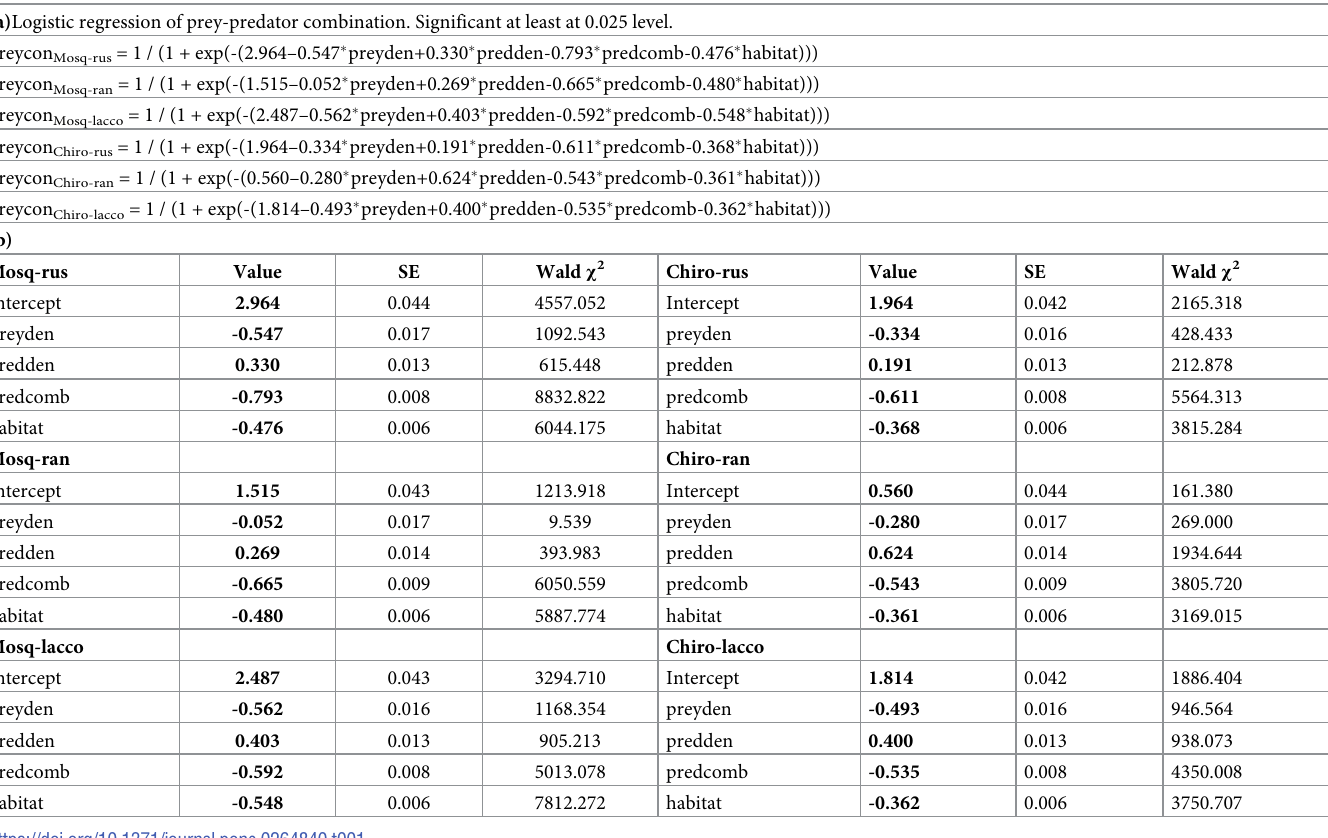
(both vegetation and pebbles when present in the habitats). On a comparative scale the preda- tors consumed higher number of mosquitoes than chironomid larvae when present separately as individual predator. Although density effects were evident for chironomid and mosquito larvae, the habitat conditions appeared to be more determining factor. For all the predators, the prey consumption was density dependent and differed signifi- cantly among the predator species. D . rusticus consumed at a greater amount than the other two predators when present as individual predators. For A . bouvieri , the trend in mosquito and chironomid larvae consumption remained similar to the rest of the heteropteran predators with highest consumption in simple conditions and lowest in complex conditions with vegeta- tion and pebbles (S3 Table in S1 File). The results of the logistic regression indicated that the shared prey mortality was influenced significantly (P < 0.001) by the prey density, predator density, predator combinations (either single or in IGP) and the habitat conditions, for both mosquito and the chironomid as prey against the three heteropteran IG predators (Table 1) except for the predator density in case of D . rusticus , and prey density in L . griseus , which were insignificant. Similar observations were also made for the IG prey mortality (Table 2), with the prey density and predator density and habitat combinations significantly (P < 0.001) contrib- uting to the IG prey mortality in the IGP system.